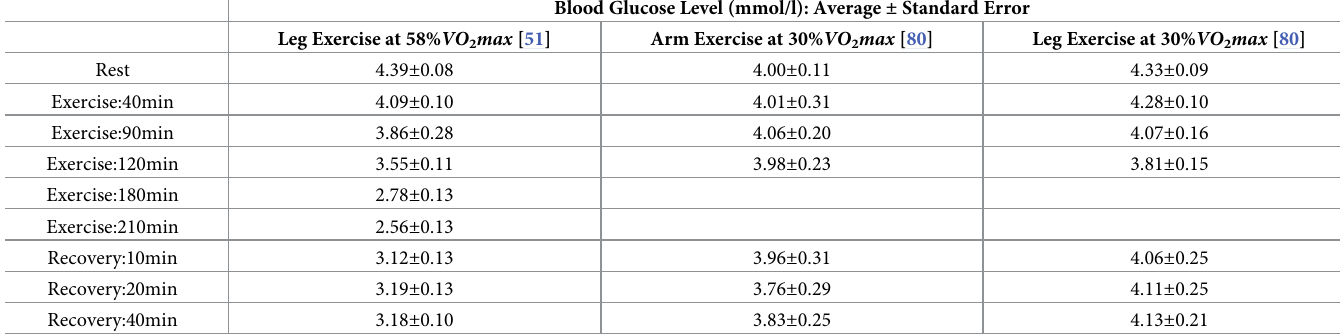
Table 7. BGL measurements reported in [51] and